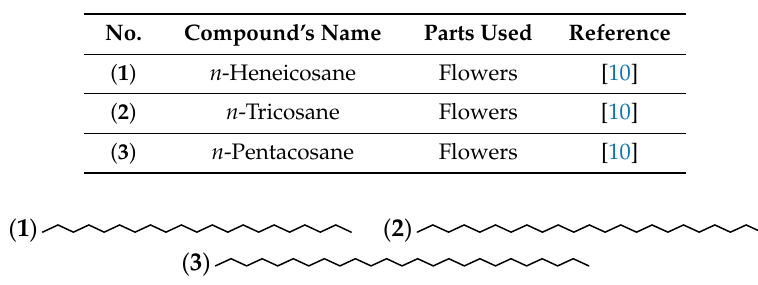
Figure 2. The structures of the hydrocarbons from A. cathartica.